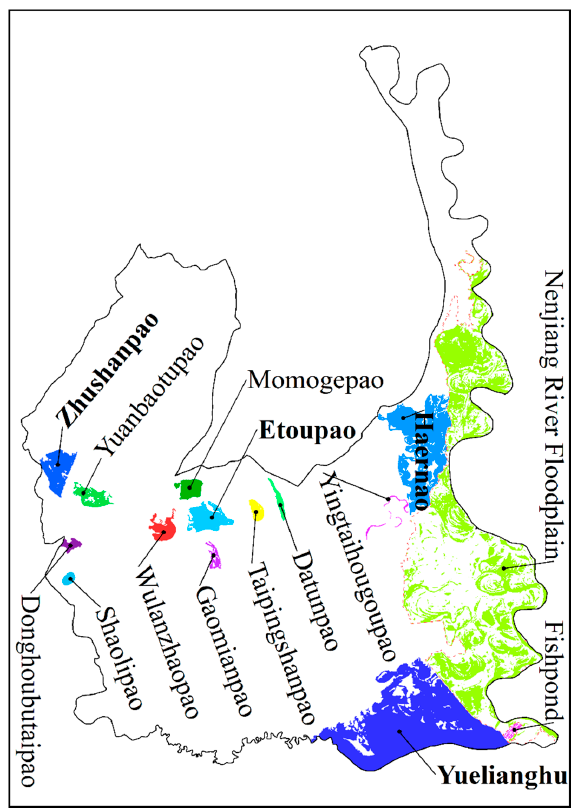
Figure 2. Major water bodies on the China’s Momoge National Nature Reserve (MNNR). Data source: Copernicus Sentinel-1 Data.